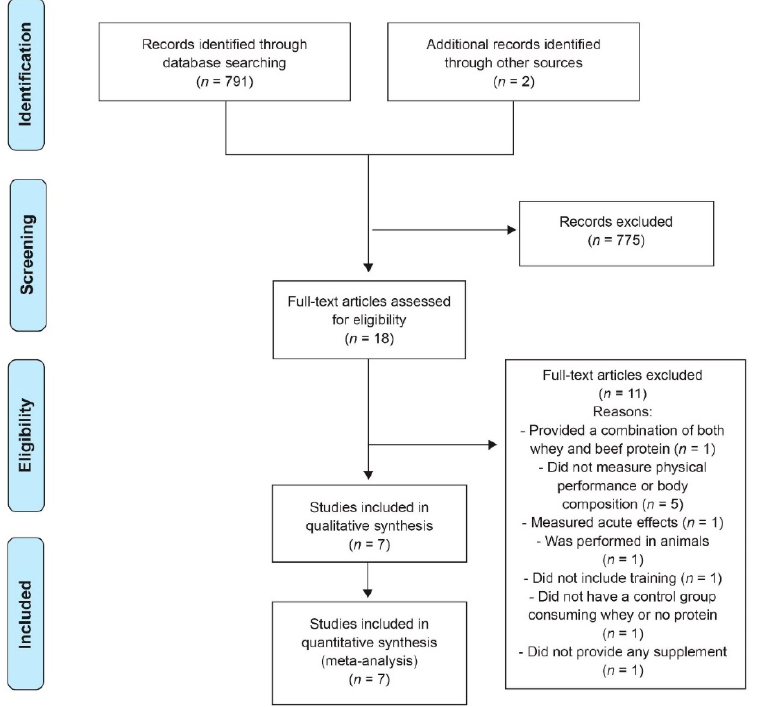
Figure 1. Flow chart of literature search.